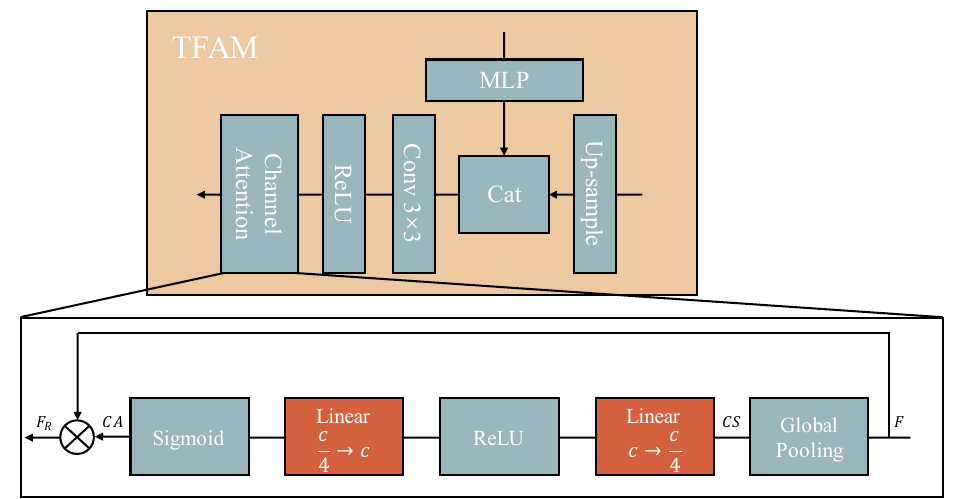
Figure 4. The architecture of the top-down feature aggregation module (TFAM). It mainly consists of the multilayer perceptron (MLP) and the channel-attention